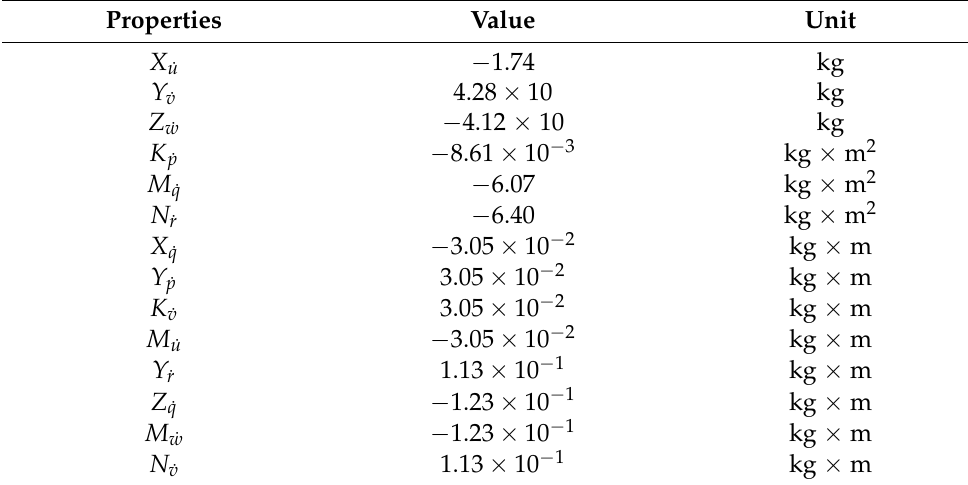
Table 5. MARES added masses.